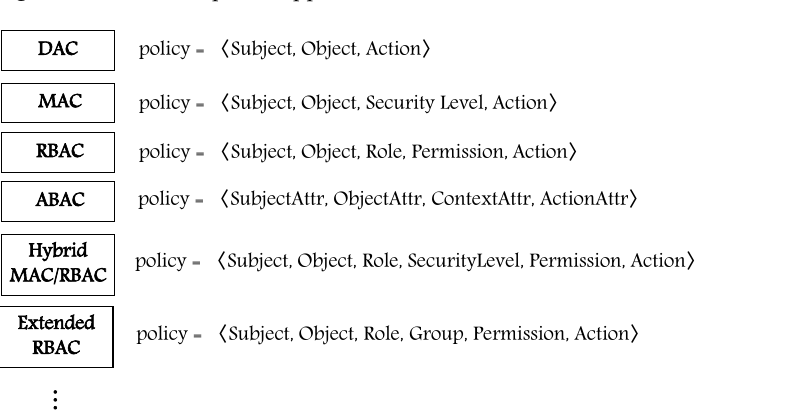
Figure 14. The development approach.